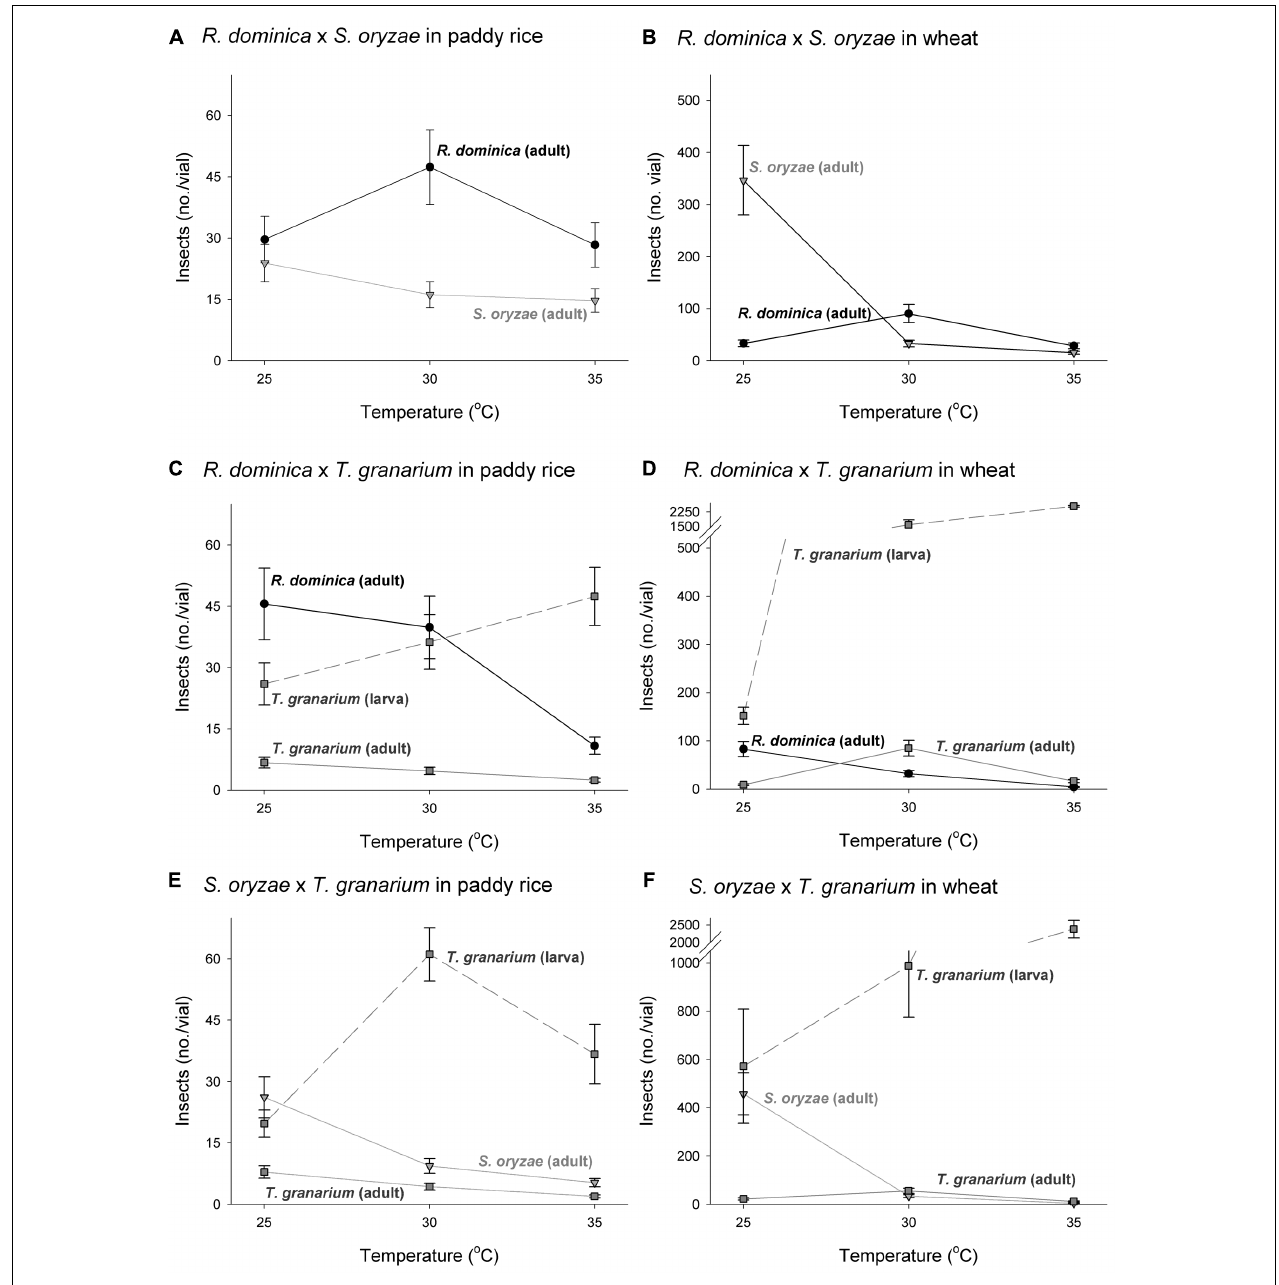
FIGURE 5 | Insect population under two-species competition at three temperature conditions in grains of two cereal host species, paddy rice and wheat. The symbols indicate the average of nine replicates and the vertical bars represent standard errors of the mean. The labels (A–F) refer to each binary group of competing species in two host grains, i.e., paddy rice (A,C,E) and wheat (B,D,F)